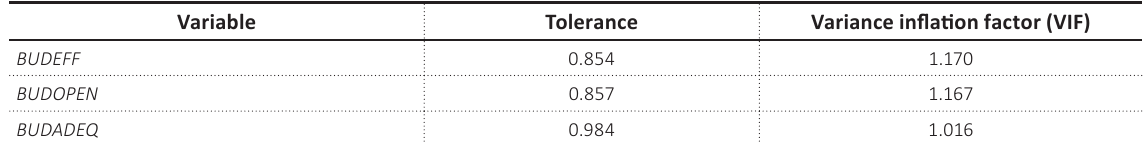
Source: Authors’ elaboration.